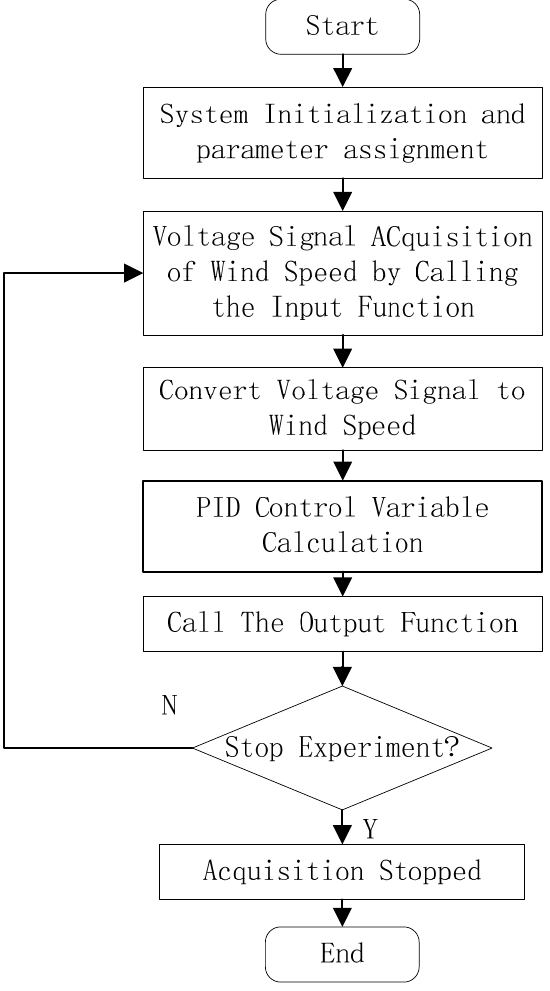
Figure 5. Flow chart of the program.